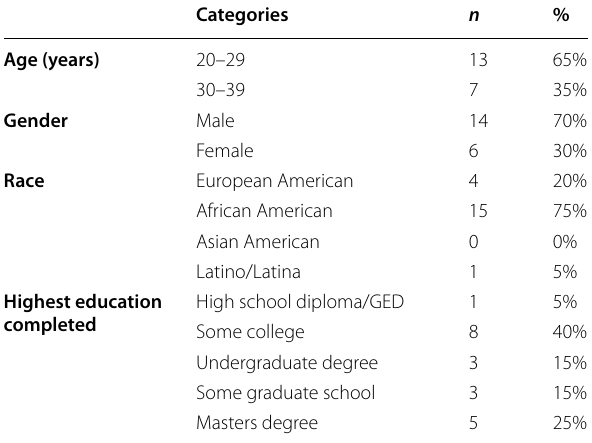
Table 1 Demographics and educational attainment of the study participants. Data are subdivided by the age, gender, race, and highest education completed of the participants. These data are presented for all 20 participants who enrolled in the study. The n represents the raw number of subjects. The percentage was calculated from all 20 participants